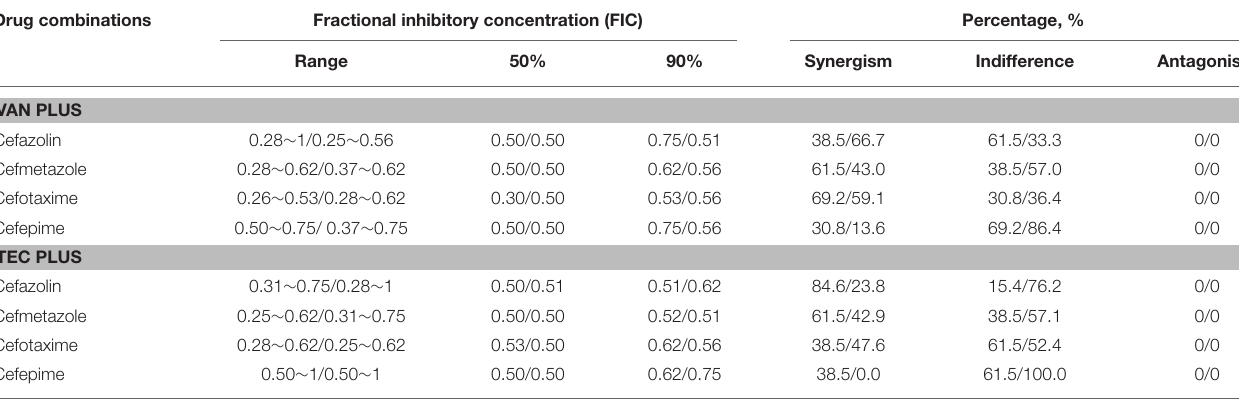
TABLE 2 | In vitro c ombination effects of vancomycin (VAN) or teicoplanin (TEC) and one of the cephalosporins evaluated by the checkerboard method for 13 high-cefazolin MIC/low-cefazolin MIC isolates of methicillin-resistant Staphylococcus aureus